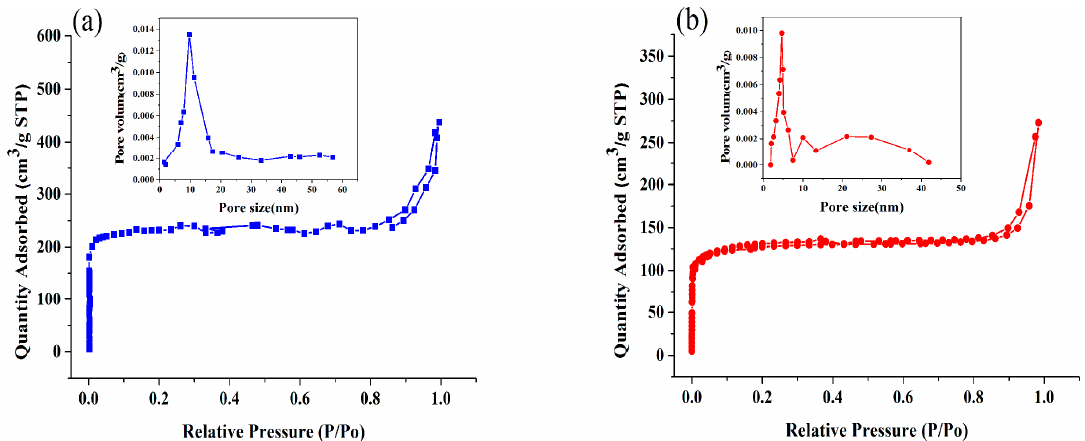
Figure 5. Nitrogen adsorption–desorption isotherms and pore size distributions (insert figures) for ( a ) ZIF ‐ 8 and ( b ) RML@ZIF ‐ 8.